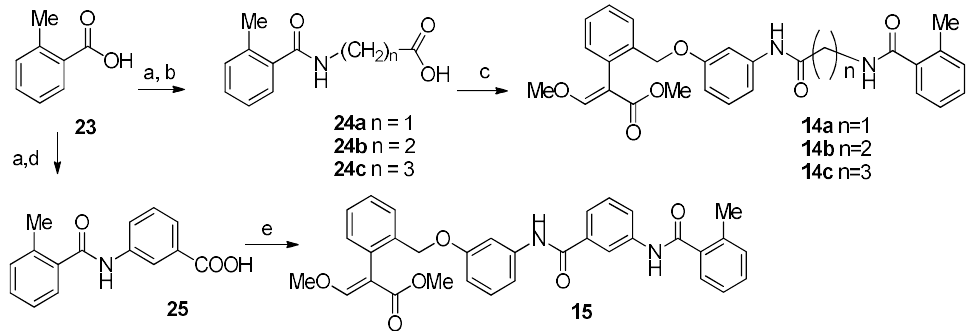
Figure 3. Mycelium growth of wild-type (WT) and QoI-resistant (RES) Pyricularia oryzae strains on control malt-extract agar media (C = control, ACT = 1% acetone) and media supplemented with 01 2 3